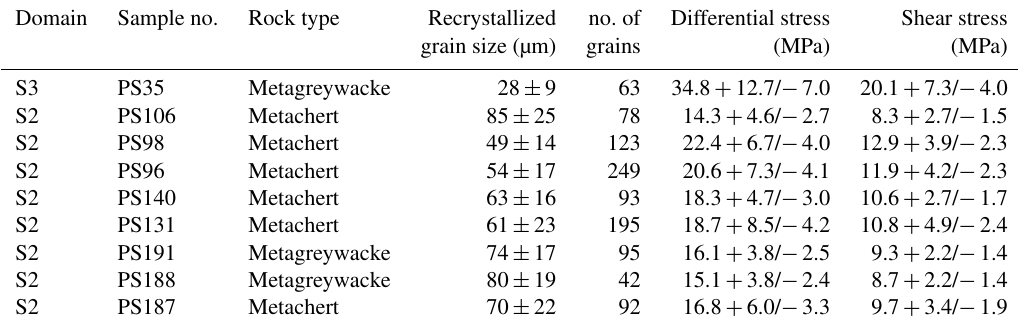
Figure 4. S1 fabric in metagreywacke and greenschist. See Fig. 2a and Table S1 for sample locations. (a) The mineral inclusions in albite outline S1. Note the differentiated cleavage. Sample PS52. (b) S1 in mafic greenschist shown by the mineral inclusions in the epidote porphyroblast. Sample 95. (c) CPO of quartz inclusions in one albite porphyroblast in Sample PS52. (d) S1 in albite grains is crenulated as shown by the trails of graphite. Sample PS109. Table 1. Stress